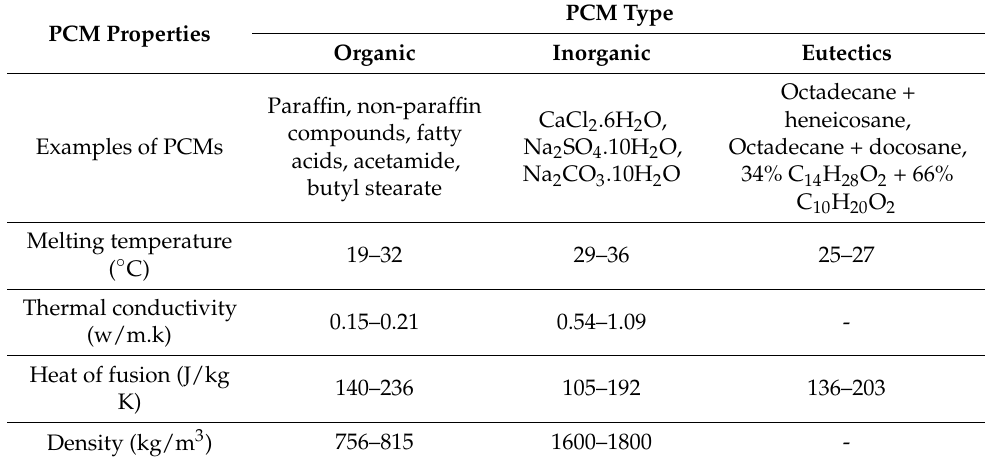
Table 1. Classification of PCMs, together with their common properties [10,12–23].